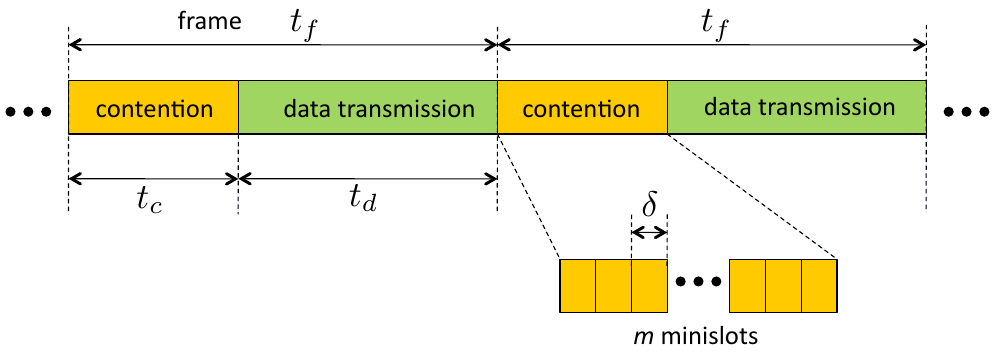
Figure 1. A time diagram for frame